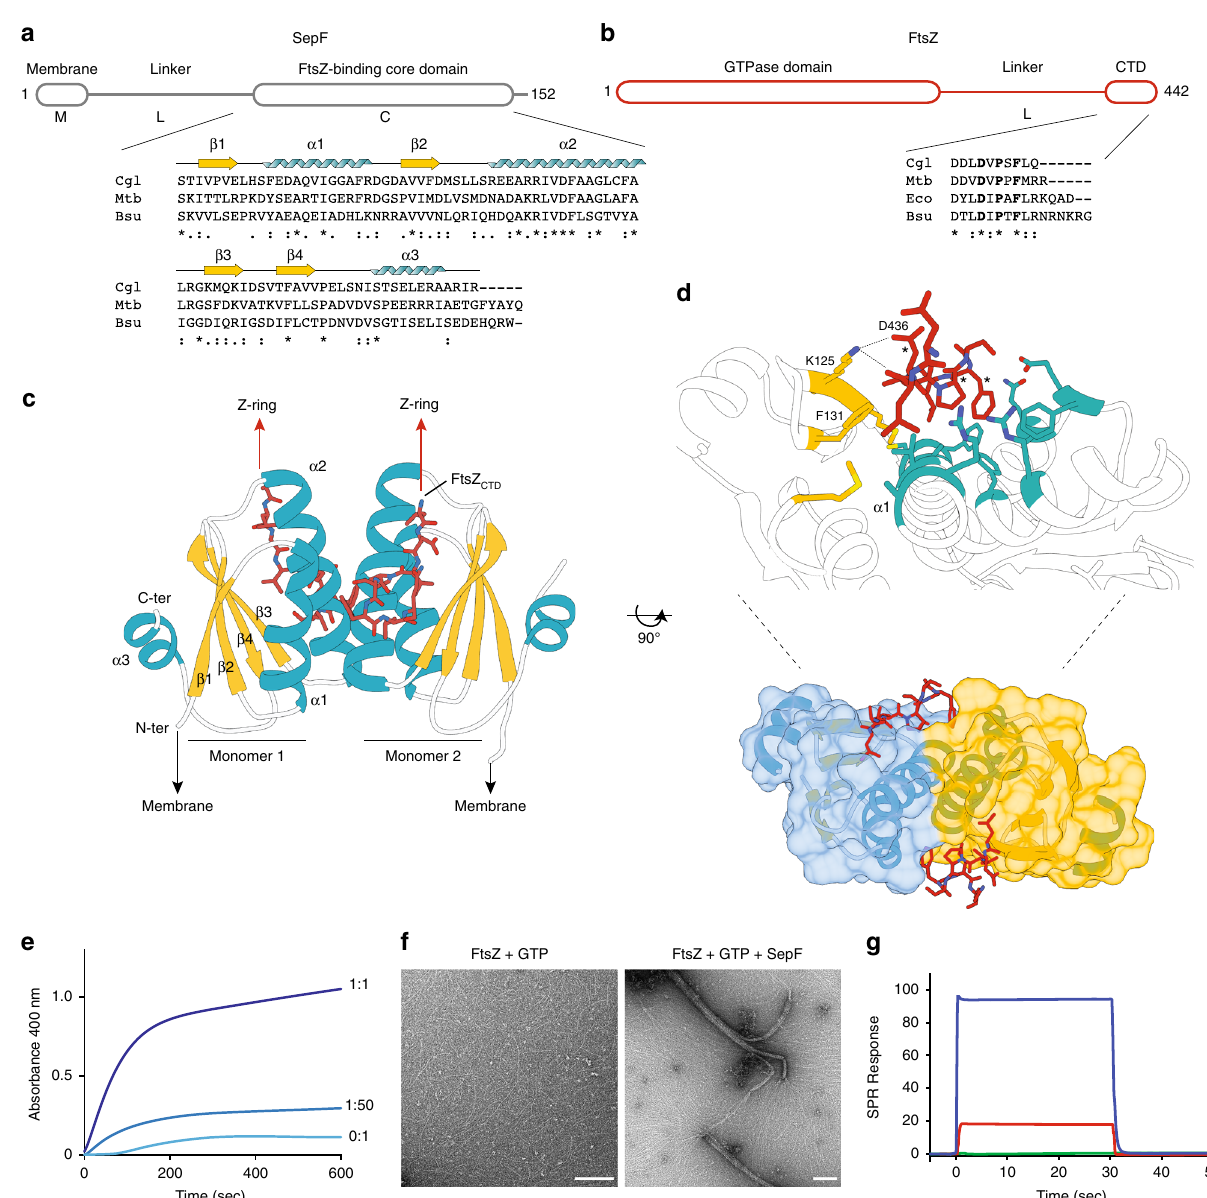
Fig. 2 Molecular characterization of the SepF – FtsZ interaction. a Schematic outline of SepF domains and sequence alignment of selected SepF homologs (Cgl, C. glutamicum ; Mtb, M. tuberculosis ; Bsu, B. subtilis ). Secondary structure elements are shown above the sequences. b Schematic outline of FtsZ domains and FtsZ CTD sequence alignment of selected homologs (Eco, E. coli ). Asterisks (*) indicate strictly conserved positions in the alignment and residues involved in SepF binding are shown in bold. c Crystal structure of the SepF dimer in complex with two FtsZ CTD peptides. The orientations of the N- and C- termini of SepF and FtsZ are compatible with membrane binding on one hand and Z-ring formation on the other. d Detailed view of the FtsZ-binding pocket in SepF showing residues involved in protein – protein interactions (see Supplementary Fig. 8 for details). Conserved FtsZ CTD residues D 436 , P 438 , and F 440 are labeled (*), and SepF residues K125 and F131 were those mutated to abolish FtsZ binding. e FtsZ polymerization in the presence of varying levels of SepF. The stoichiometric SepF:FtsZ ratios are indicated for each curve. f Negatively stained EM micrographs of FtsZ fi laments in the absence (left) and presence (right) of SepF. The polymers in the left-hand panel have a width of about 4 nm, which corresponds to the width of FtsZ. The bundles shown in the right-hand panel range in width from 20 – 60 nm. Scale bars are 150 nm. The data shown are representative of experiments made independently in triplicate. g SPR responses in resonance units (RU) for 200 μ M FtsZ CTD interacting with immobilized SepF (blue), SepF F131A (red), and SepF K125E/F131A (green). The detailed SPR results are shown in Supplementary Fig. 9. Source data are provided as a Source Data fi